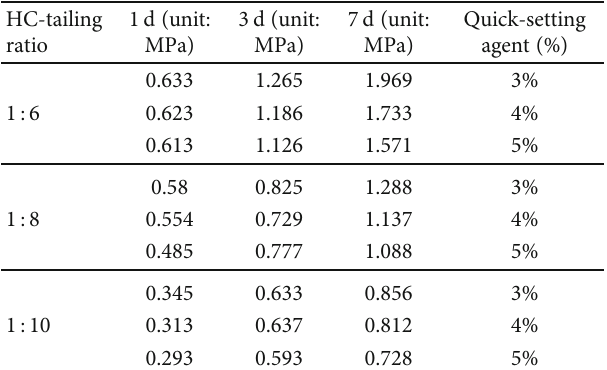
Table 4: The average compressive strength of the test blocks (unit: MPa).